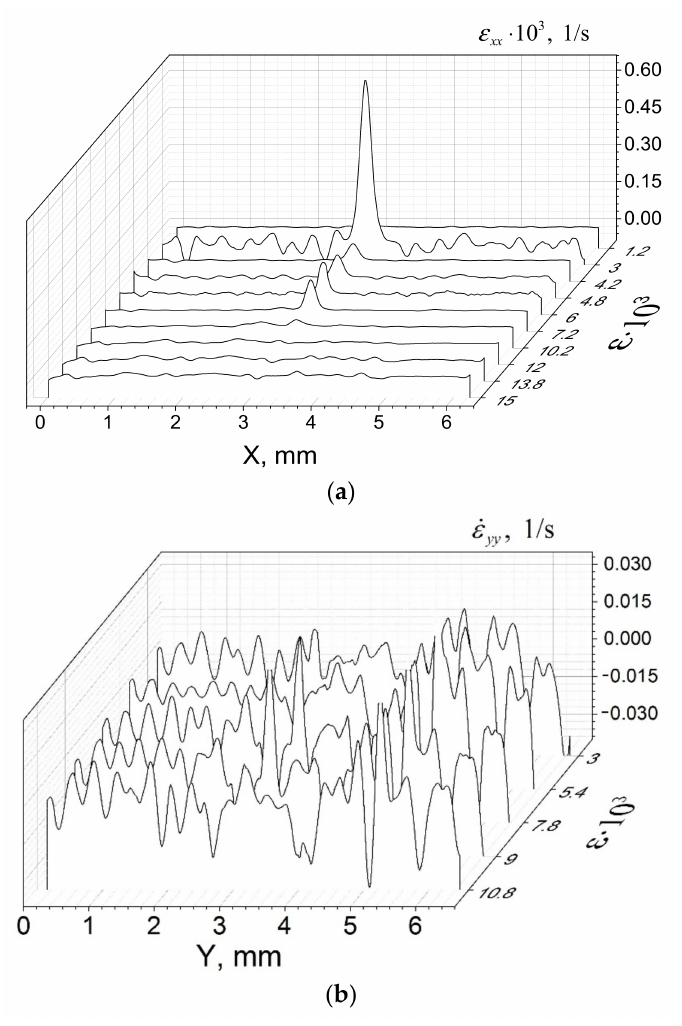
. ε xx ( X , Y = Y m /2 ) ( a ) and